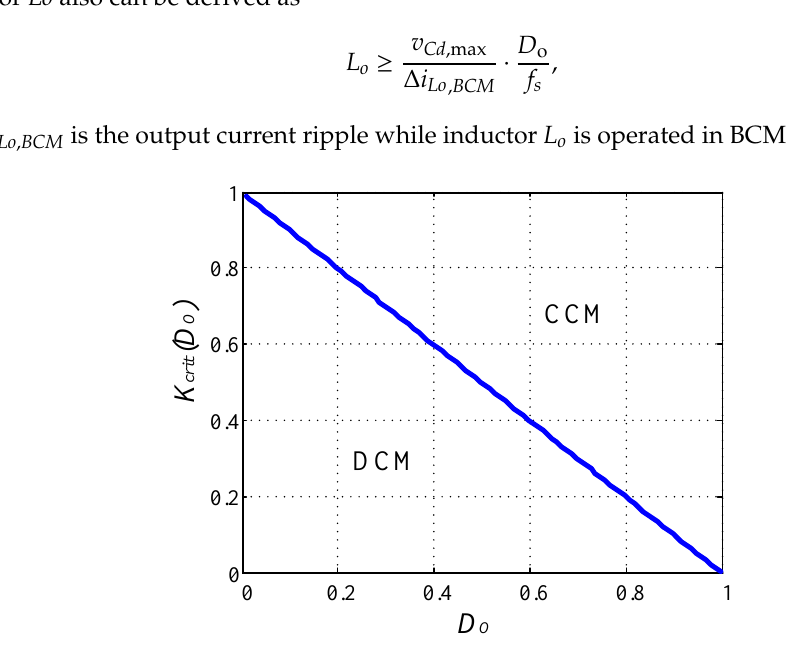
Figure 14. Proposed step up/down AC/DC converter K cirt ( D o ) vs. D o .